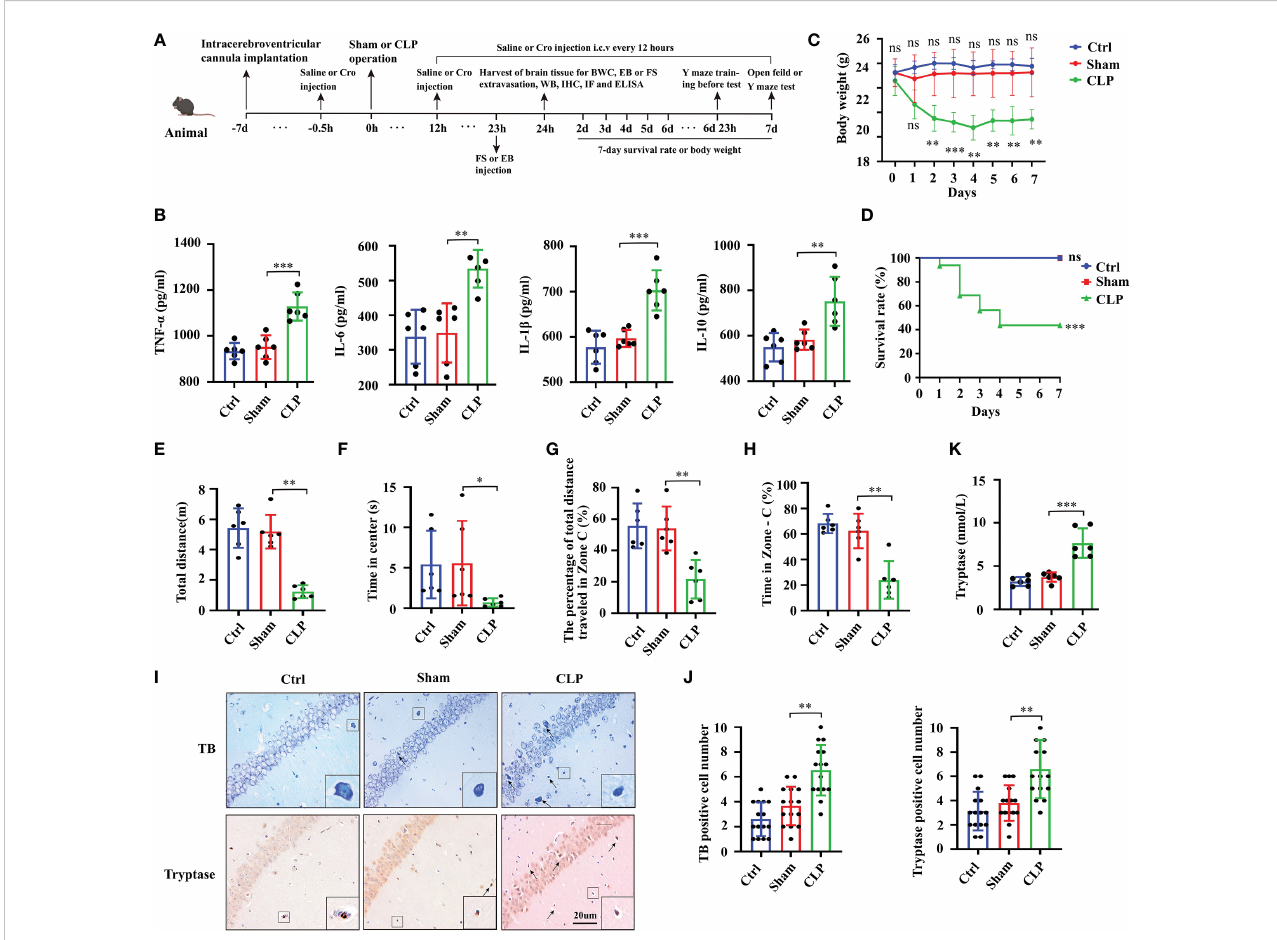
FIGURE 1 Sepsis-induced neuroin fl ammation, cognitive de fi cits and mast cells activation in brain tissues. (A) Schematic timeline of the experimental procedures. (B) The levels of TNF- a , IL-6, IL-1 b and IL-10 in mice hippocampus tissues were detected by ELISA (n=6). Body weight (C) and survival rate (D) were observed in 7 days following surgery (body weight: n=6; survival rate: n=15). The total movement distance (E) and the time in the center zone (F) in the open fi eld test, and the movement distance in zone C (G) ) and the time in zone C (H) in the Y maze test were recorded to analyze the cognitive changes (n=6). (I) TB staining and tryptase IHC staining were used to detect activated MCs in the hippocampus CA1 region (400x, black arrow indicates MCs, n=6). (J) Quanti fi cation of TB and tryptase staining positive cells in the hippocampus CA1 region (n=6). (K) Levels of tryptase in the hippocampus CA1 region were detected by ELISA (n=6). MCs: Mast cells, CLP: Cecal Ligation and Puncture, SAE: Sepsis-associated encephalopathy, TB: Toluidine blue, IHC: immunohistochemistry. (ns: no signi fi cance, * p<0.05, ** p<0.01, ***